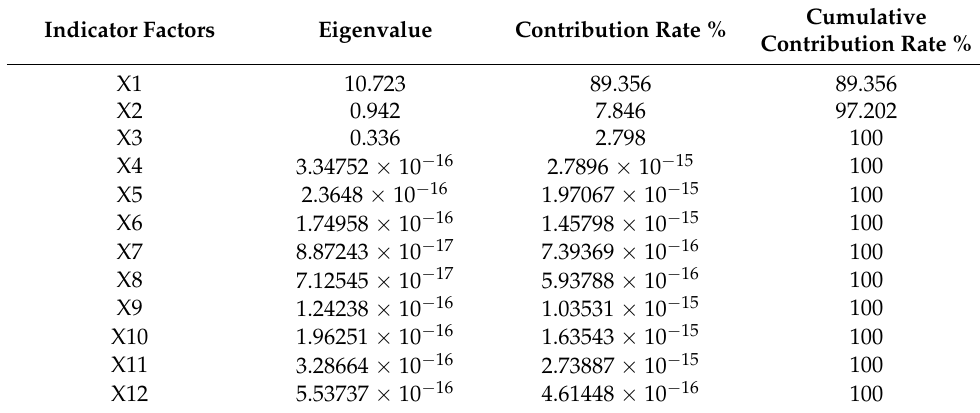
Table 7. Driver eigenvalues and main contribution rate.